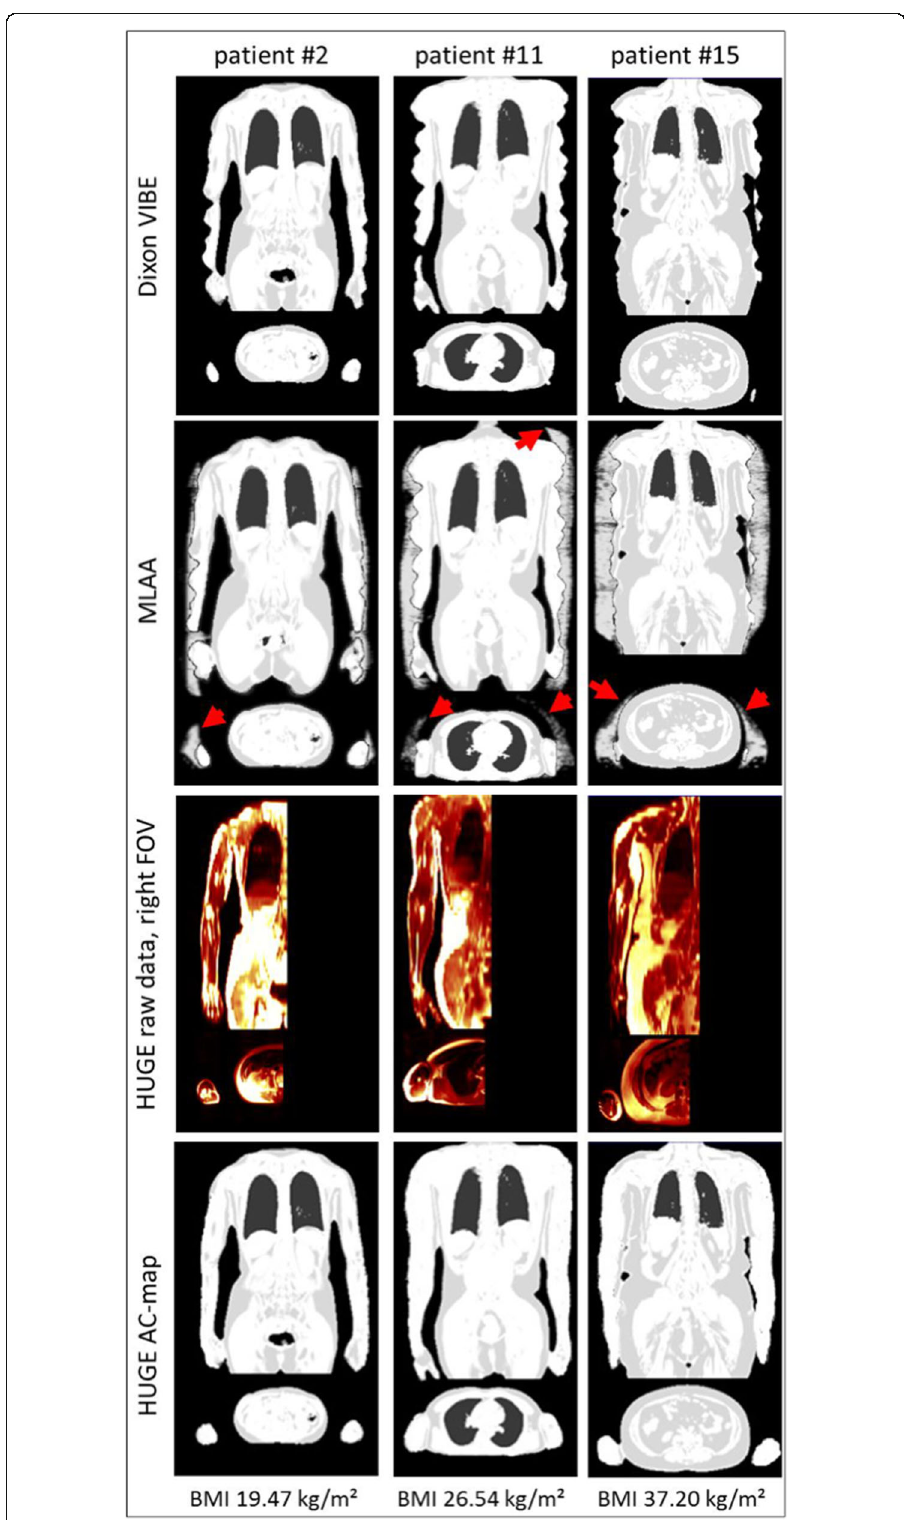
Fig. 1 (See legend on next